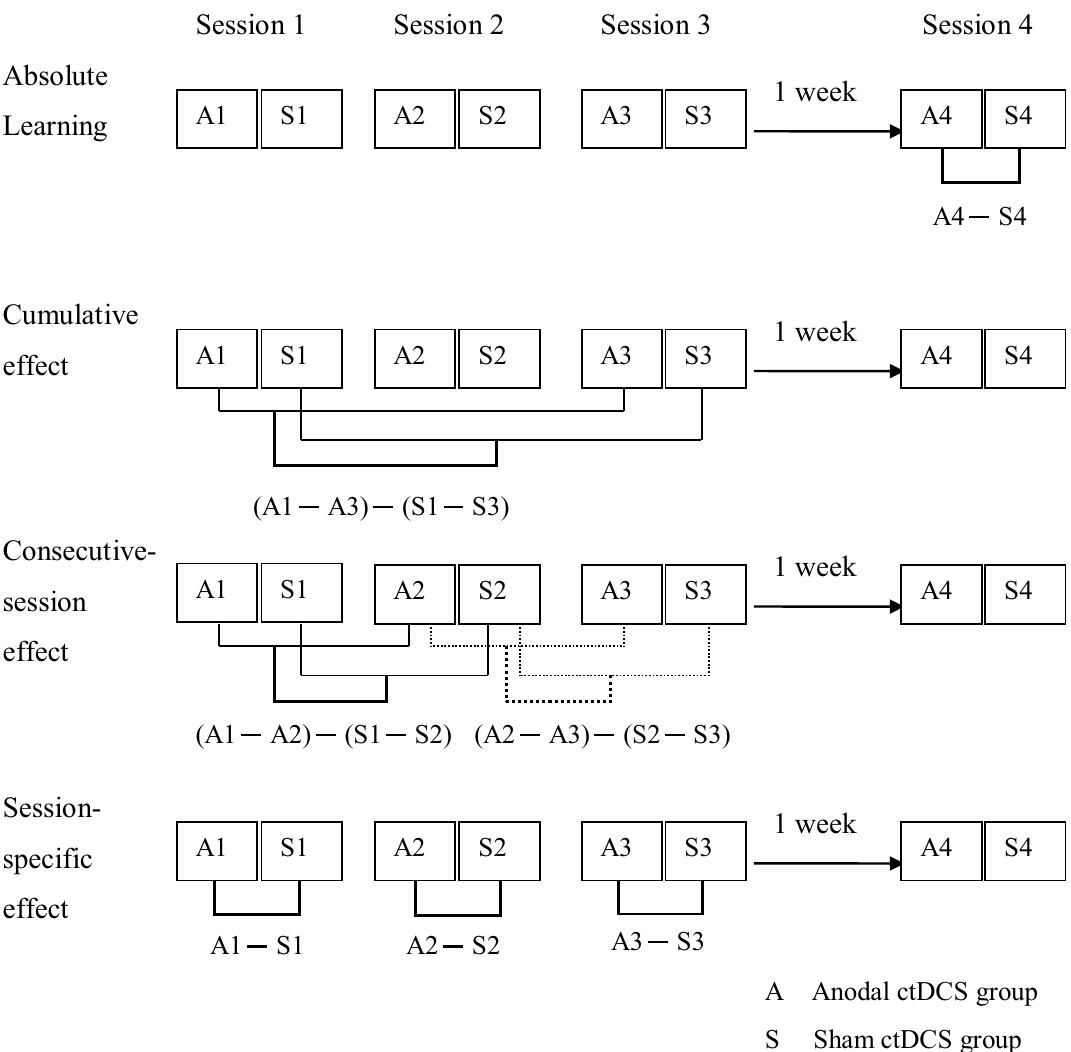
Figure 4. Statistical analysis for absolute learning, cumulative effect, consecutive-session effects and session- specific effect measurement time